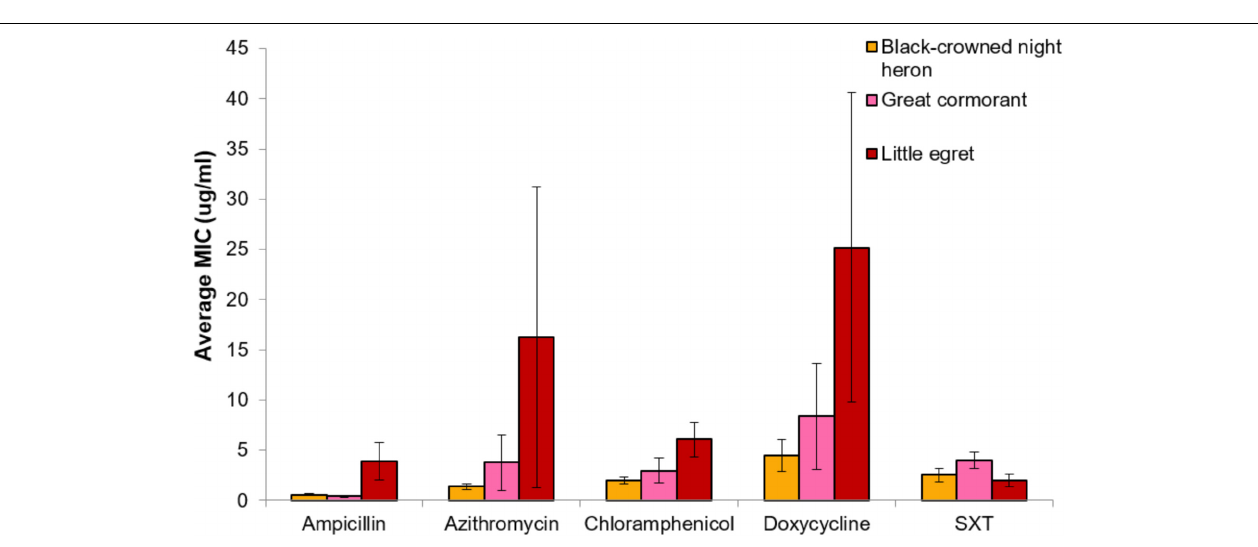
resistant bacterial strains are 2 × 10 6 and 2.3 × 10 4 people